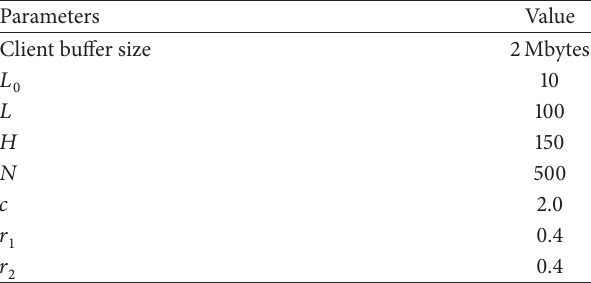
Table 1: Parameter settings for